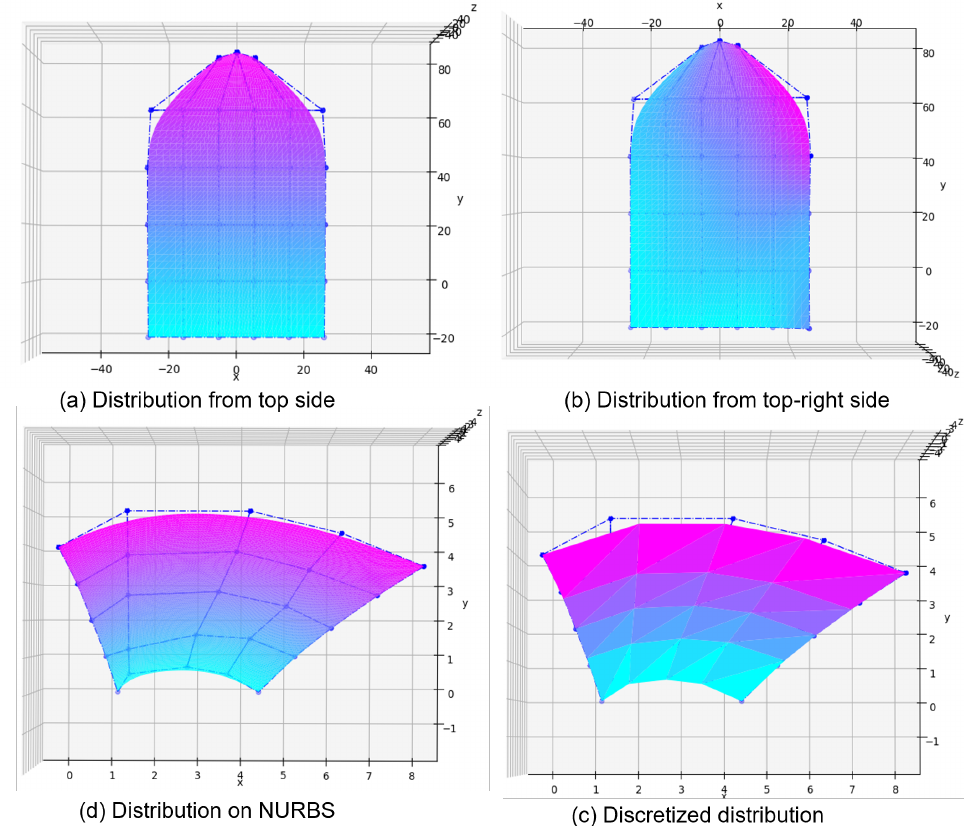
Figure 13. Gradient distribution of NURBS function: ( a ) A tower shape including top-side gradient, ( b ) A tower shape including right top-side gradient, ( c ) A curved bean discretized gradient, ( d ) A curved beam including top-side